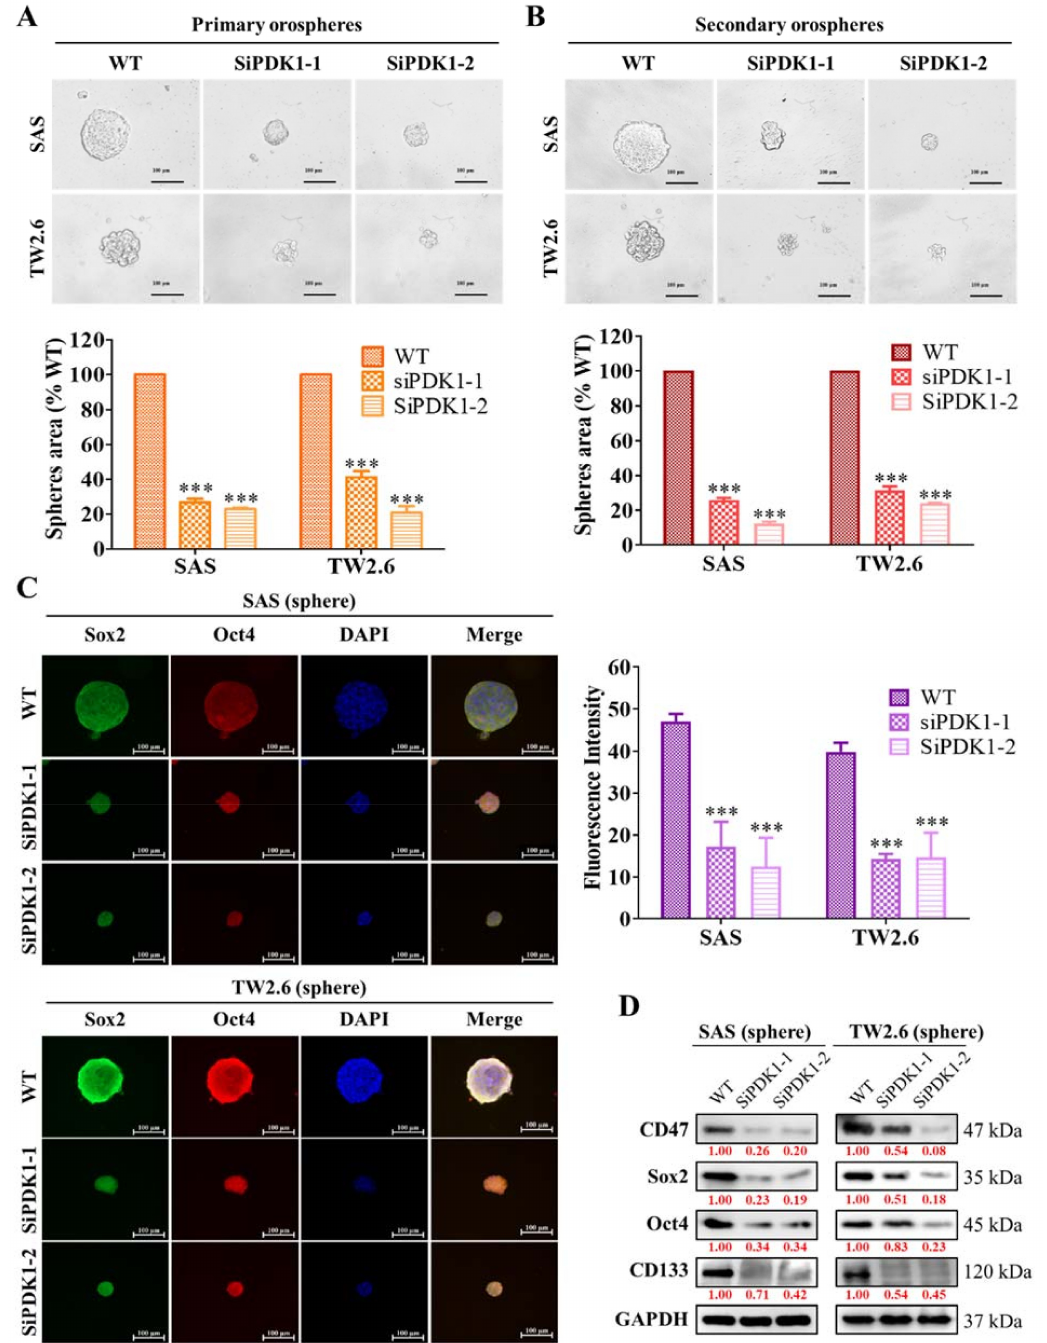
Figure 3. PDK1 modulates CSC-like phenotypes in OSCC cells. ( A ) Primary and ( B ) secondary orosphere generation of SAS and TW2.6 cell lines were reduced after transfection with siPDK1-1 and siPDK1-2. ( C ) Immunofluorescent staining showing the effect of PDK1 silencing on the expression of Sox2 and Oct4 proteins in spheres formed by SAS and TW2.6 cells. ( D ) Effect of PDK1 knockdown on the expression level of CD47 , Sox2, Oct4, and CD133 proteins in SAS and TW2.6 sphere. GAPDH served as a loading control. All assays are representative of experiments performed four times in triplicates. WT, wild type; Sp, orosphere; blue stain = DAPI, nuclear staining. All data are representative of the experiment conducted four times in triplicate and are expressed as mean ± SEM. *** p < 0.001; scale bar 100 µ